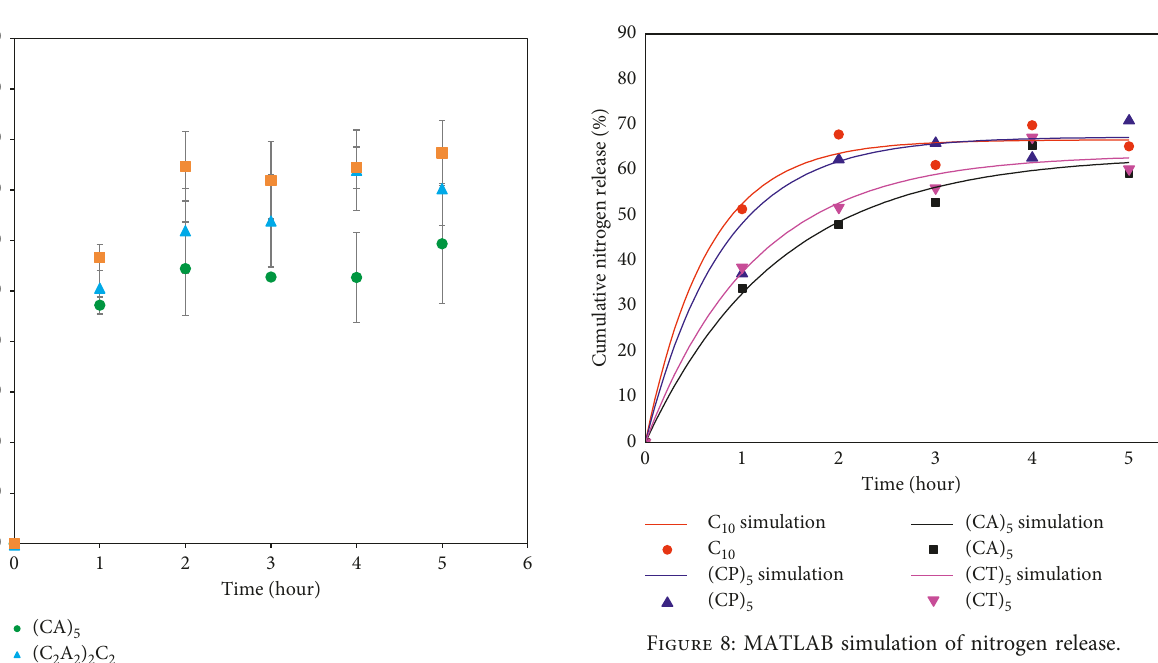
5 , (b) chitosan-pectin (CP) 5 , and (c) chitosan-TPP (CT) 5